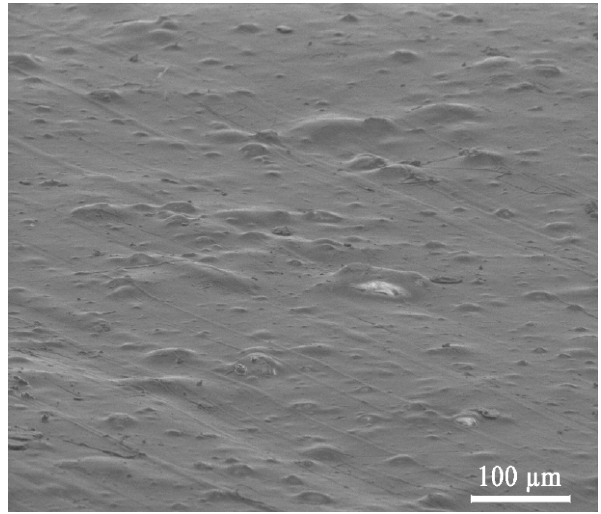
Figure 2 . SEM image of composite surface for PLLA/HAp. Figure 2. SEM image of composite surface for PLLA /